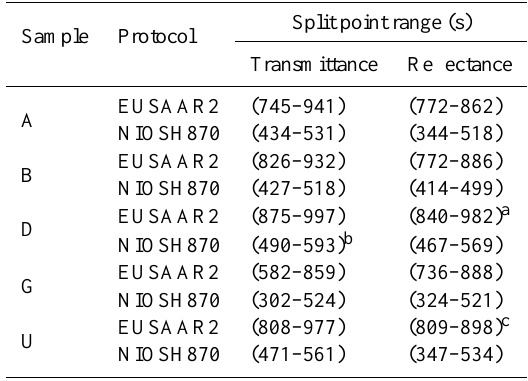
Table 4. Split point ranges as reported by all participants, per sam- ple, protocol and optical